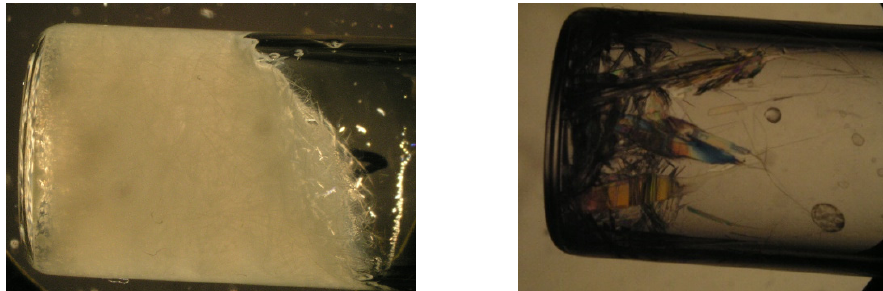
Figure 8. Crystals of flufenamic acid grown in dichloromethane gel of G1 ( left ) and with solution evaporation ( right ).